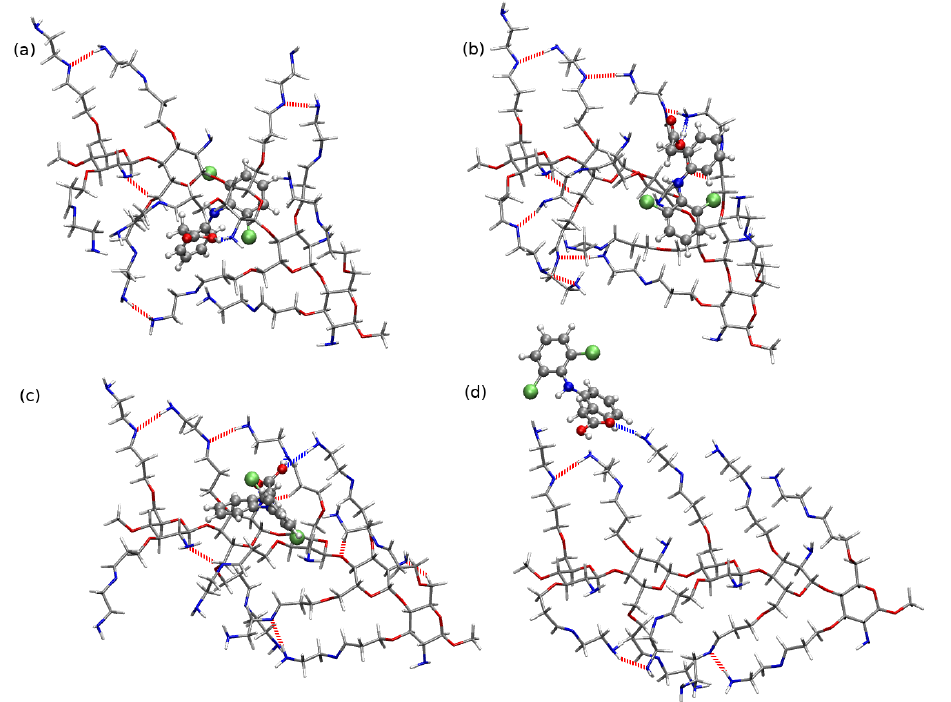
Figure 15. B97-D3/6-311++G(d,p) interaction in most attractive and the weakest CS5(NH 2 ) 2 :DFH complexes: ( a ) CS5(NH 2 ) 2 :DFH 14 , ( b ) CS5(NH 2 ) 2 :DFH 10 , ( c ) CS5(NH 2 ) 2 :DFH 8 and ( d ) CS5(NH 2 ) 2 :DFH 5 .